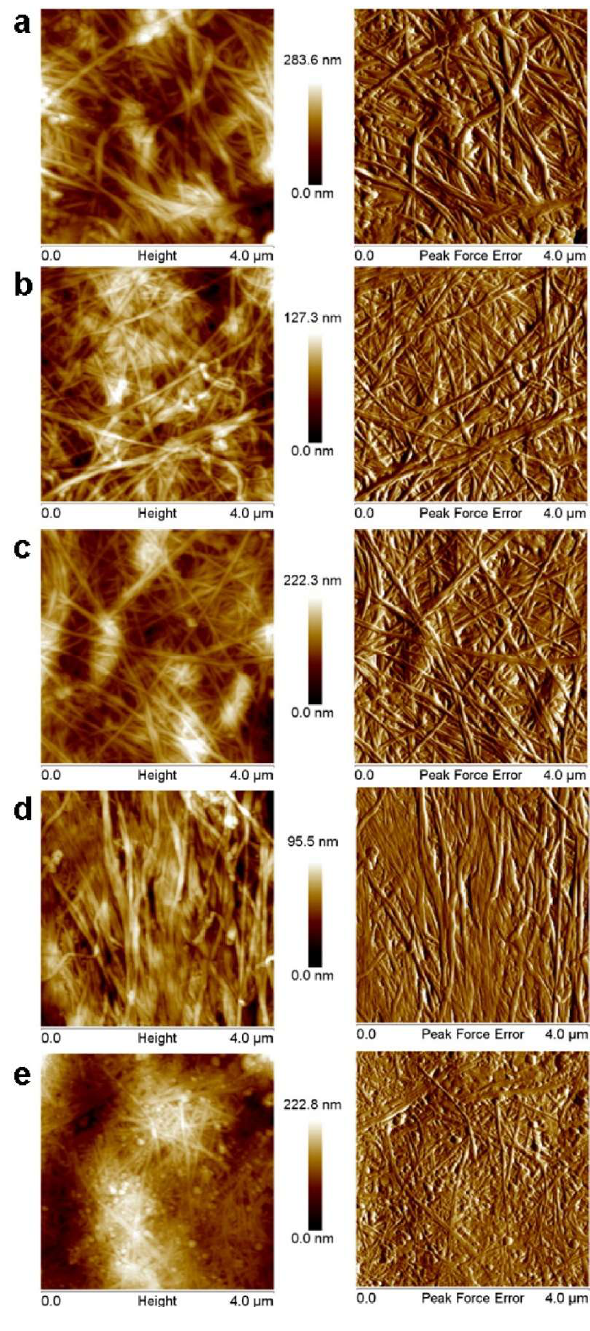
Figure 1. AFM topographic and peak force error images of BC ( a ), BC-Ac ( b ), BC-AA ( c ), BC-APS ( d ), BC-VS ( e ).